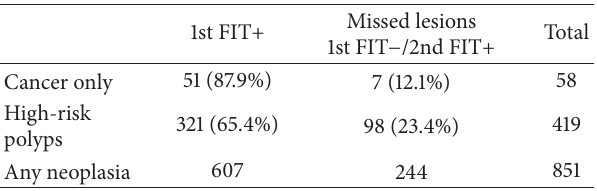
Table 2: Colorectal cancer and high-risk polyps missed with one FIT